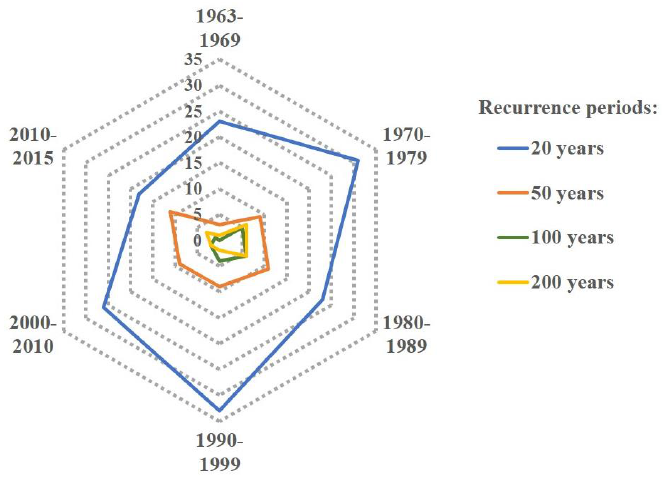
Figure 7. Number of extreme precipitation events for the four recurrence periods in different decades.